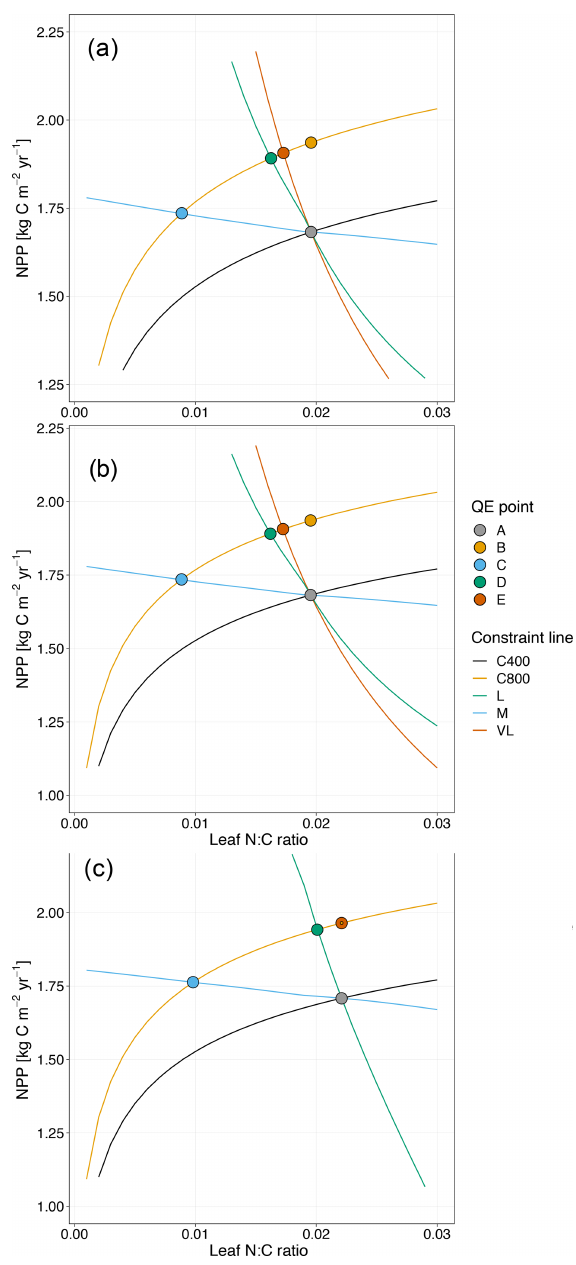
Figure 4. Graphic interpretation of the effect of different nutrient uptake assumptions on plant response to CO 2 fertilization. Func- tions are (a) plant N uptake as a function of a constant coefficient, with a variable wood N:C ratio assumption, (b) plant N uptake as a saturating function of root biomass linearly depending upon the mineral N pool, and (c) plant N uptake as a saturating function of the mineral N pool linearly depending upon root biomass. Constraint lines C400, C800, M, L, and VL refer to photosynthetic constraints at CO 2 = 400ppm, CO 2 = 800ppm, medium-term, long-term, and very-long-term nutrient recycling constraints, respectively. Point A is the quasi-equilibrium point at CO 2 = 400ppm, point B is the in- stantaneous response point at elevated CO 2 , and points C, D, and E are the M-, L-, and VL-term equilibrium points at elevated CO 2 . The N uptake coefficient is set to 1yr − 1